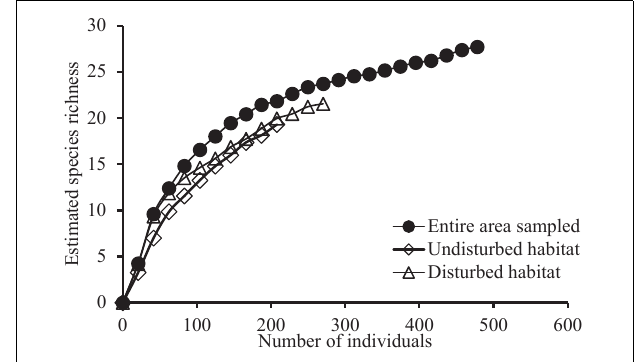
FIGURE 3 | Estimated species richness (Jackknife 1) of bats for the two habitat types investigated in the Afromontane biome of western